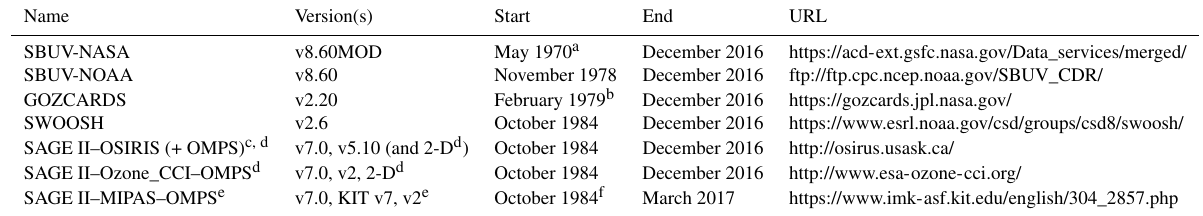
Table 1. Merged satellite data sets used in the present study. The URLs serve as an entry point only, and do not always provide the newest and most complete data set used here. See text for references.